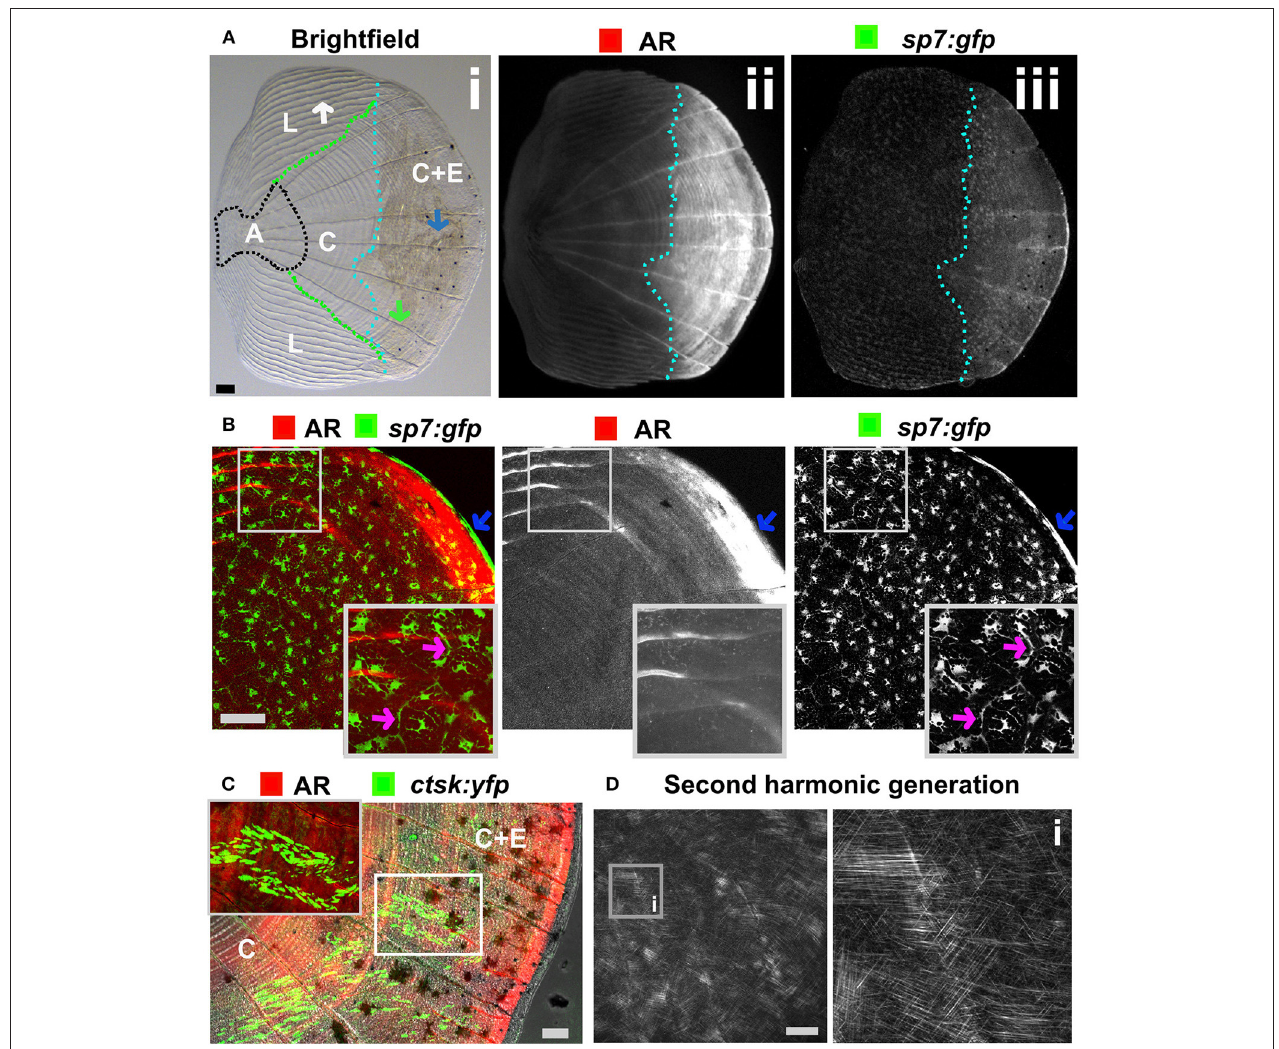
FIGURE 5 | Zebrafish elasmoid scale structure and bone cell types. (A) Single scale from the flank of a 3 months old fish carrying the sp7:gfp osteoblast reporter transgene (green) and stained for Alizarin Red S (AR, red). Whole scale is shown in bright field (i) and gray scale images for AR (ii) and GFP (iii) in the top panels. The brightfield image (i) depicts the anterior anchor region (A, black dotted line boundaries), the lateral circuli (L, green dotted line boundaries, white arrow), central region (C, surrounded by black, green, and light blue dotted lines), and central region covered by epidermis (C + E, light blue dotted line, with grooves by green arrow) with enhanced mineralization. (B) Confocal images showing a merge image of osteoblasts ( sp7:gfp transgenic fish, green) abundantly distributed over the freshly harvested scale and AR staining (red). Individual channels are depicted in gray scale images. Note increased mineralization at the edge of the scale corresponding increased GFP presence (blue arrows). Insets focus on the lateral circulus and note osteoblast cytoplasmic protrusions (pink arrows). (C) Confocal images visualizing osteoclasts with cathepsin K (ctsk) YFP reporter expression (green), mineralization by AR (red), and brightfield (gray). Note that YFP positive cells were predominantly seen in the central region with epidermis (C + E) and distal edges of the central region (C) . (D) Multiphoton forward scattering (second harmonic generation (SHG), 880nm wavelength) visualizes collagen fibrils in an ethanol fixed scale. Inset (i) shows the organization of collagen fibrils in a plywood structure. Wildtype strains (panel): TL/EKK (A) , TL (B) , AB/TL (C) . Scale bars 100 µ